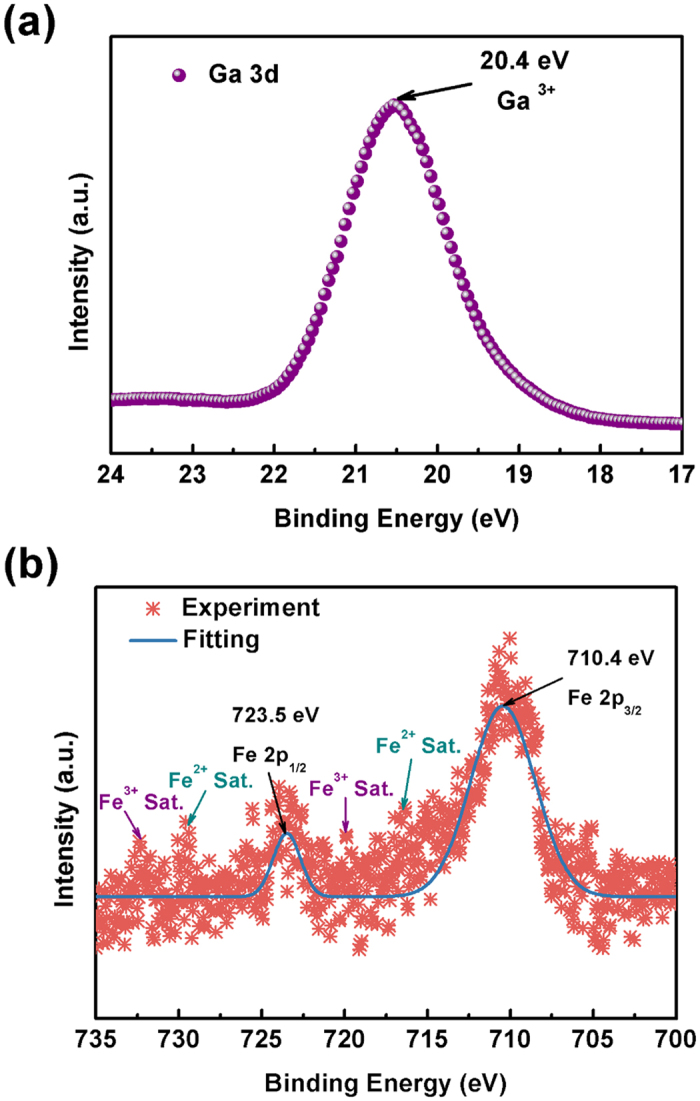
XPS spectra of Ga 3d (a) and Mn 2p (b) core level for the Ga2O3/Fe(50) multilayer thin film.